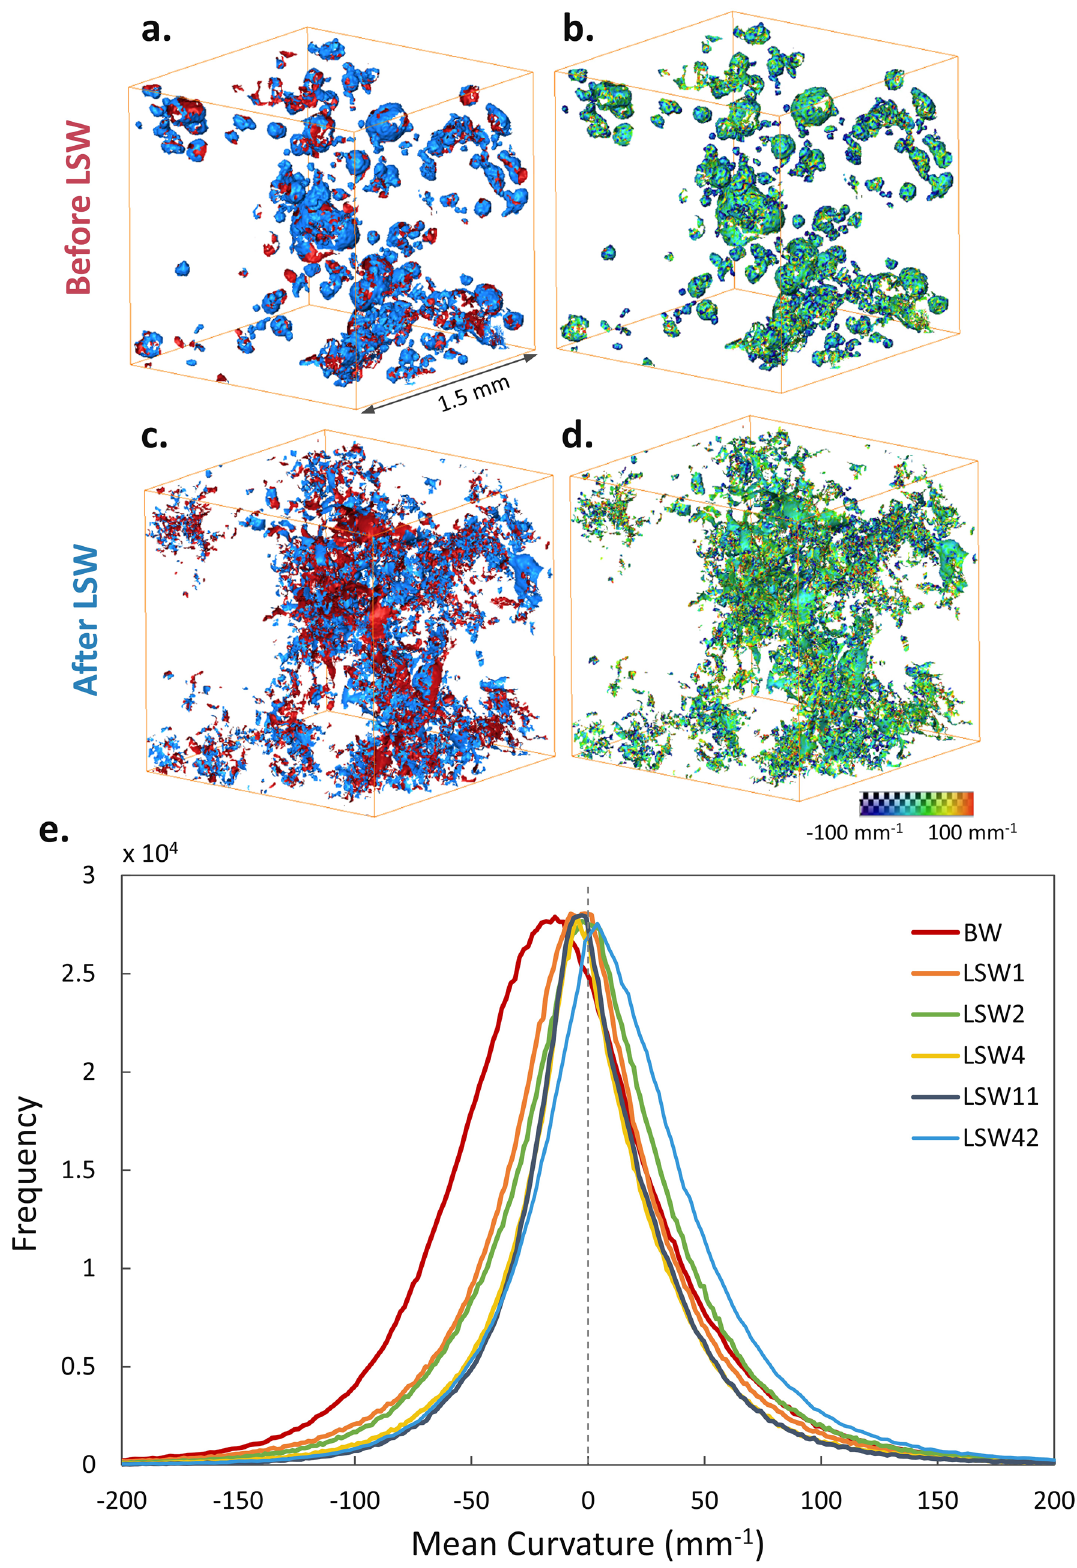
Figure 5. Three-dimensional view of smoothed oil–brine interfaces, from a 1.5 mm 3 sub-volume, before and after waterflooding ( a,c ) and their measured mean curvatures ( b,d ). Histograms of the mean curvature values measured before and throughout waterflooding ( e ). The interfaces and mean curvatures were extracted from 3D X-ray images using Avizo 9.5 sofware (https:// www. fei. com/ softw are/ amira- avizo/)